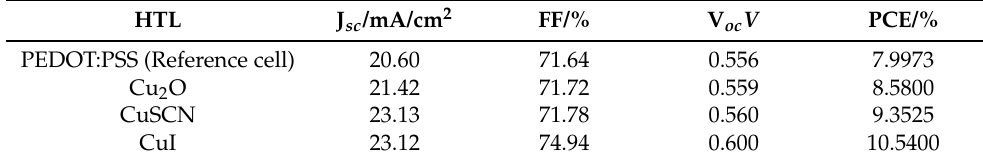
Table 6. Photovoltaic properties obtained using the different HTL materials. HTL J sc /mA/cm 2 FF/% V oc V PCE/% PEDOT:PSS (Reference